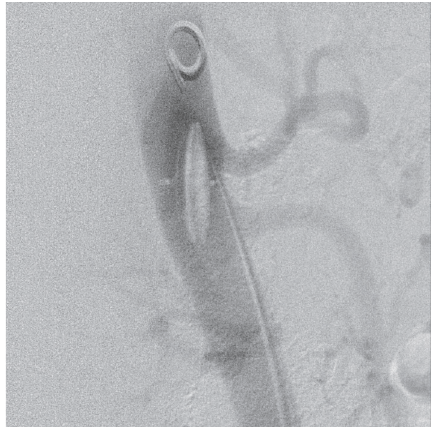
Figure 3: Digital subtraction angiography confirming embolized patent foramen ovale occlusion device within abdominal aorta.